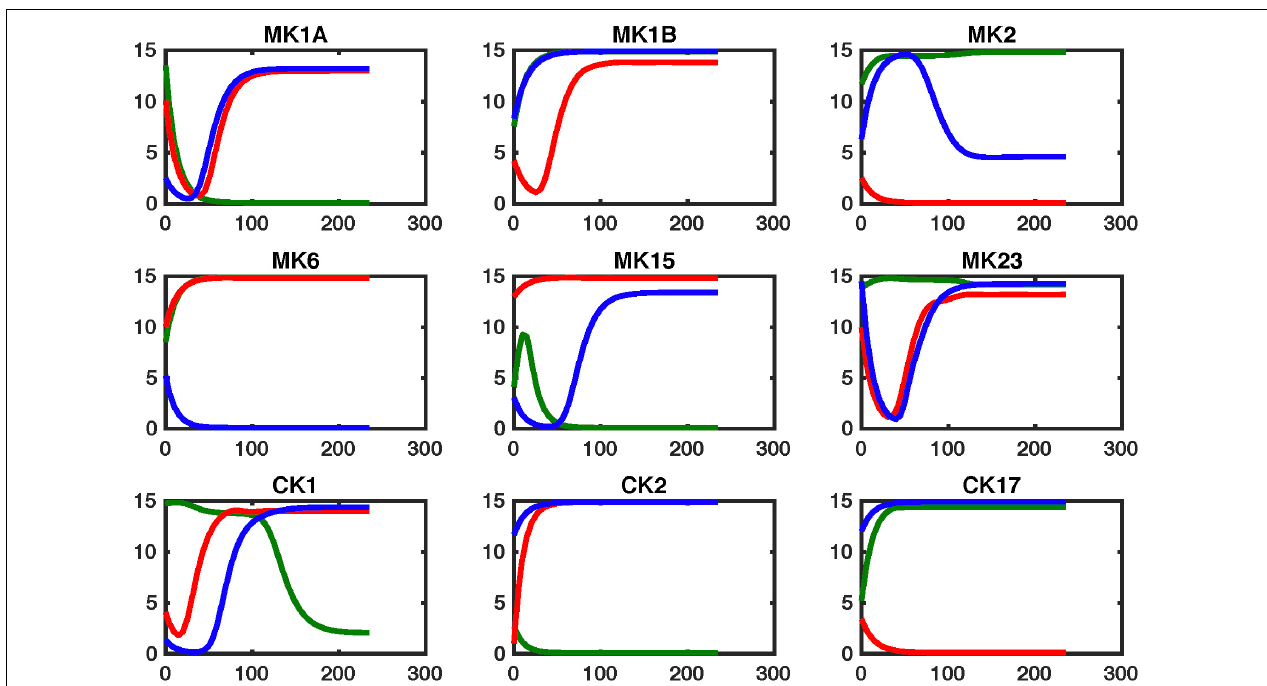
FIGURE 5 | Simulating regulatory circuit response to MK6 and CK1 antagonism. Simulated response to a step perturbation applied to the characteristic circuits for GWI (GWI, red line), healthy control (HC, green line), as well as the pharmaceutically edited GWI network (Treated, blue line). Improved adherence to output from the healthy control circuit are produced for cytokine sets CK17and MK1B, with transient restorative effects on MK2 and MK15. This is accompanied by significant worsening in MK6